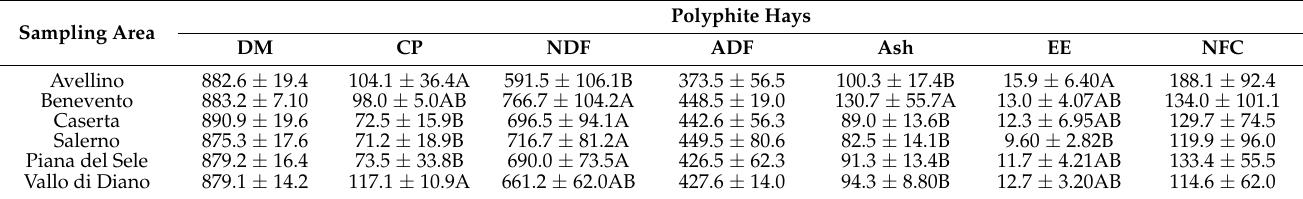
Table 3. Chemical composition (g/kg as fed; mean ± SD) of polyphite hays according to the sampling